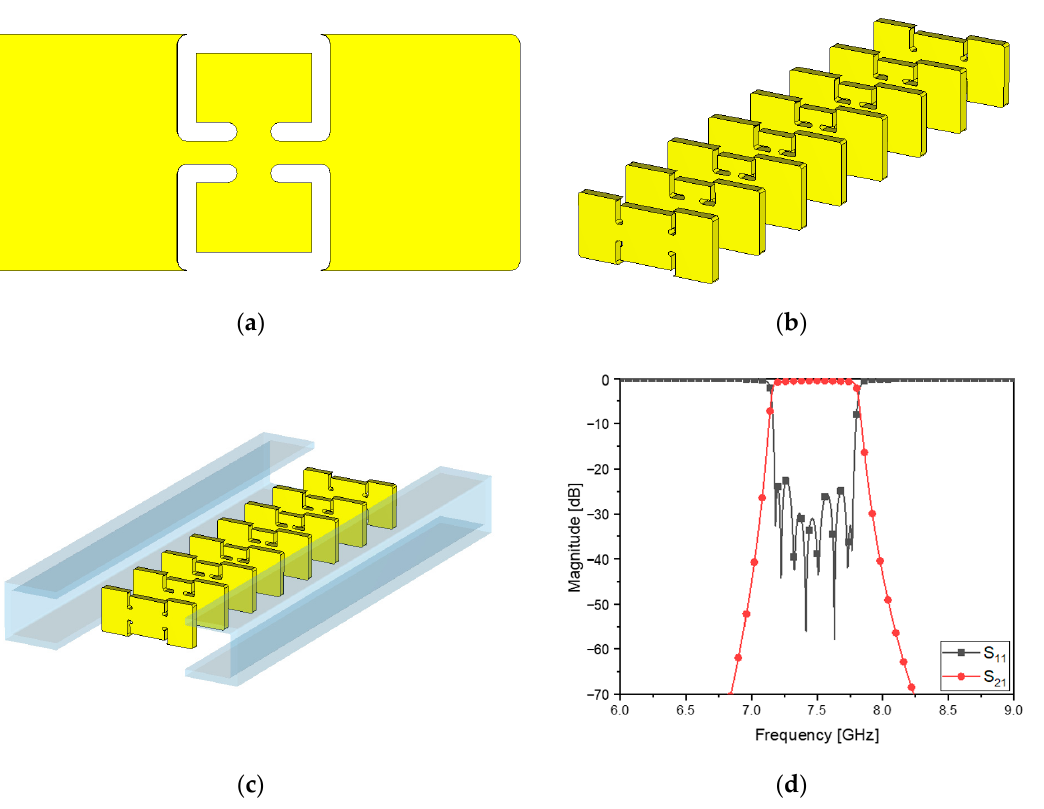
Figure 7. Realistic geometry of the eighth-order WG ZOR BPF: ( a ) front view of the thin resonator with the round corners, ( b , c ) 3D structure and ( d ) S 11 and S 21.